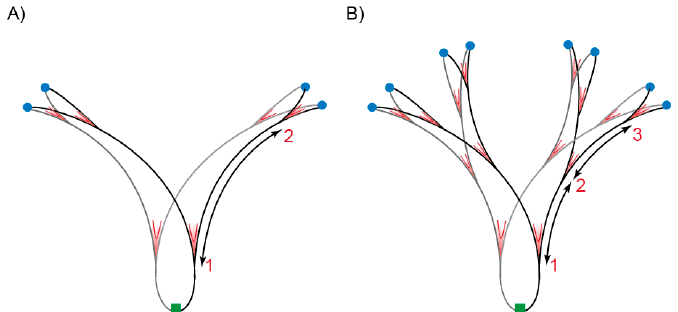
Figure 1. Distribution of replication forks during normal replication and hyper-replication. Schematic representation of a chromosome in the process of replication in cells growing with a doubling time of ~30 min; ( A ) normal replication and ( B ) hyper-replication. Origin of replication ( oriC ) regions are marked in blue and the terminus region in green. Ongoing replication forks are indicated in red (V marks). Numbers indicate the number of replication rounds. The distance between replication forks, represented by arrows, is shorter in hyper-replicating cells.